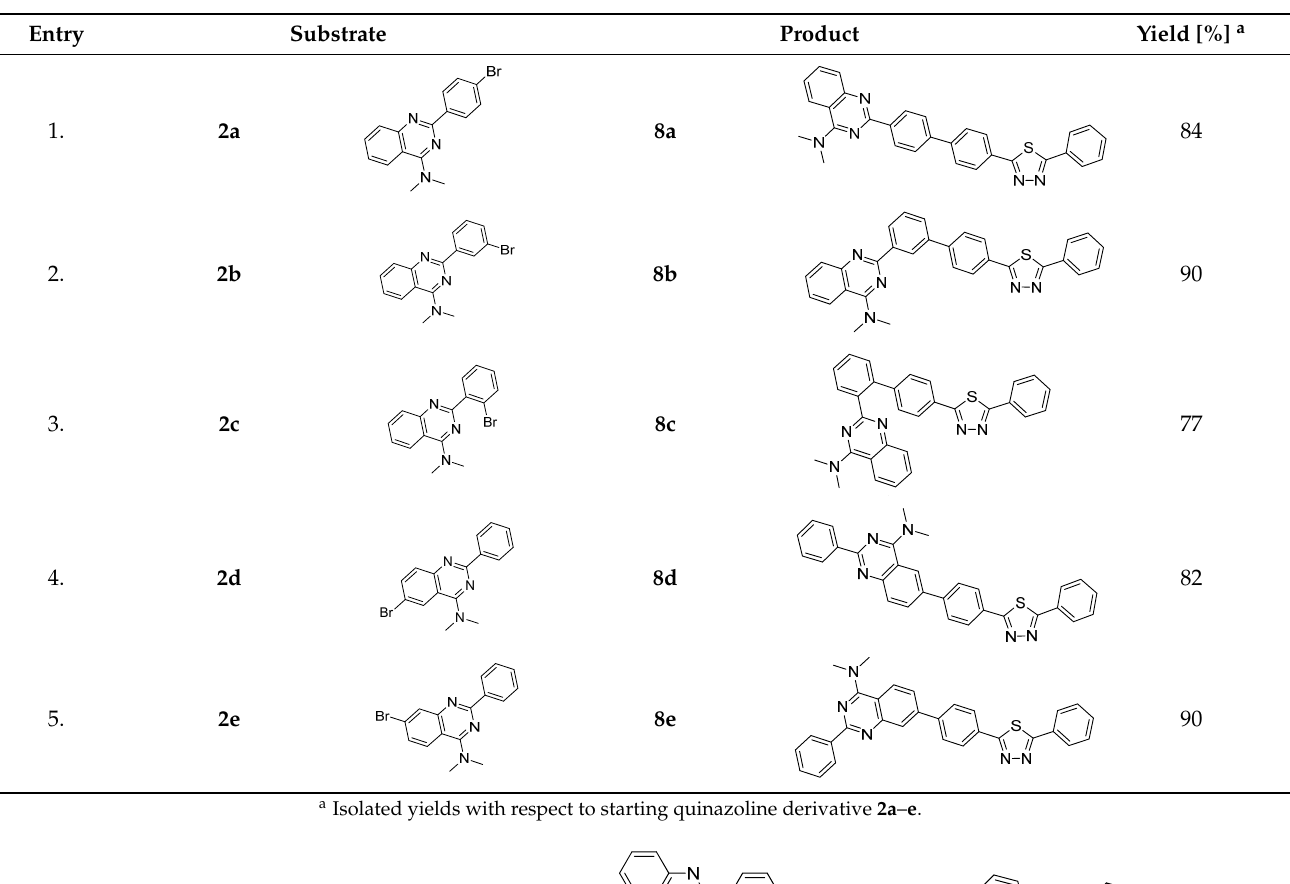
Table 2. Unsymmetrical quinazolinylphenyl-1,3,4-thiadiazole derivatives ( 8a-e ) synthesized via Suzuki cross-coupling